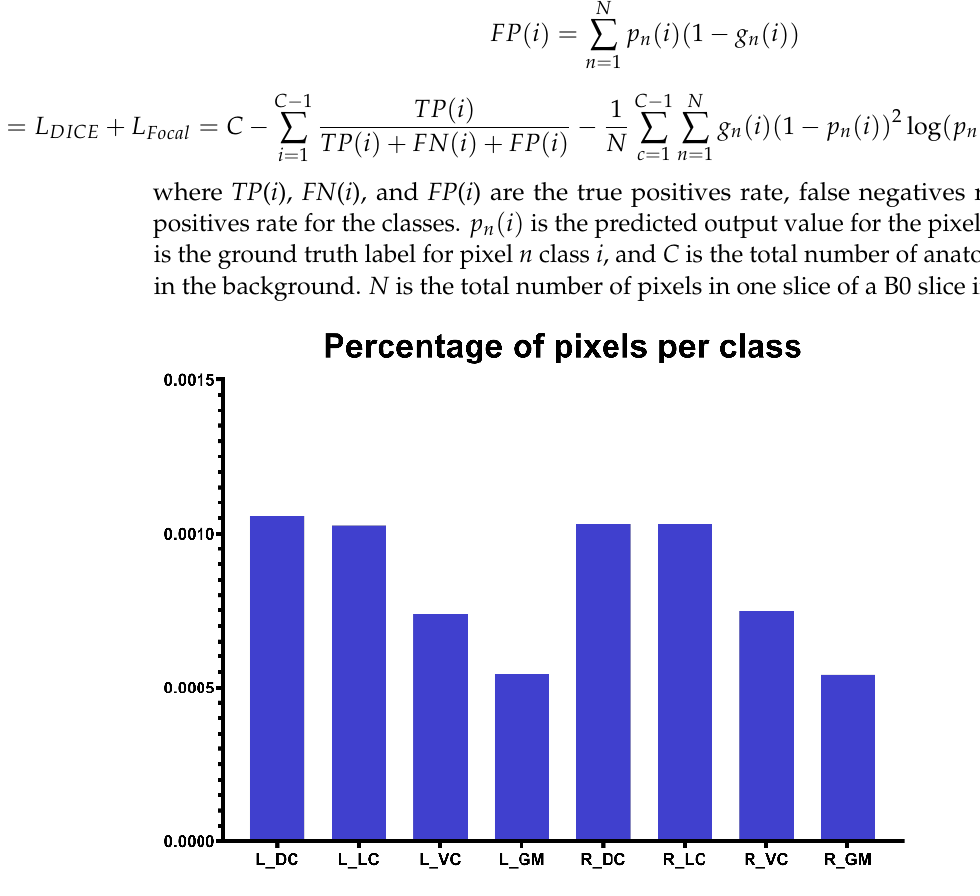
Figure 3. The percentage of pixels for each class on DTI images.